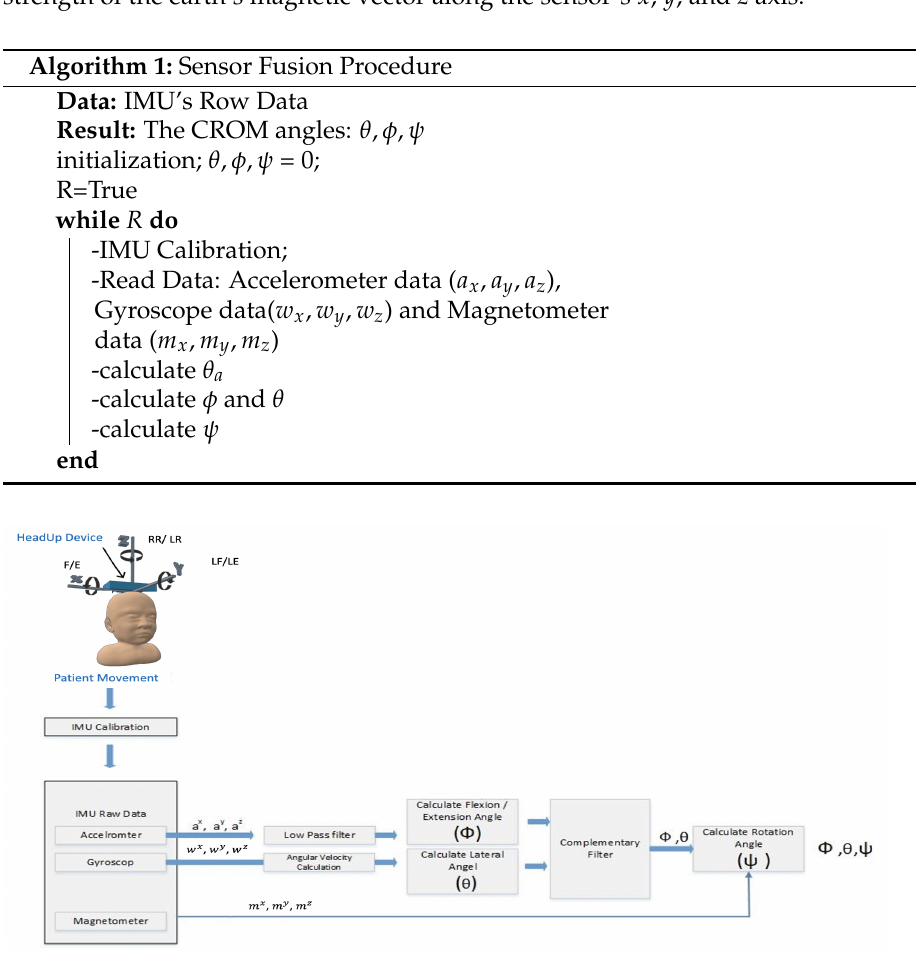
Figure 10. HeadUp SFA and filtering